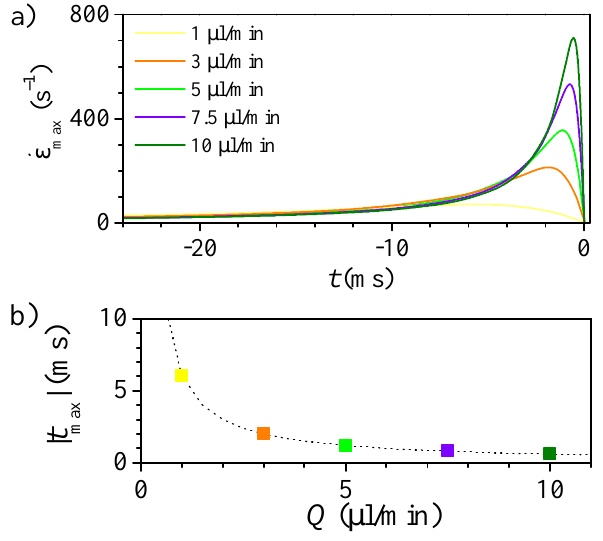
Figure 10. Strain rate versus time to reach the neck ( a ), and time from the maximum to the neck ( b ) for nozzle 8 at different flow rates. The dashed line in ( b ) correspond to the curve 6.05 × Q − 1